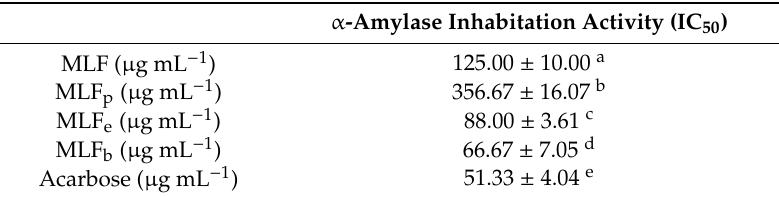
Table 6. α -Amylase inhabitation of the MLF.